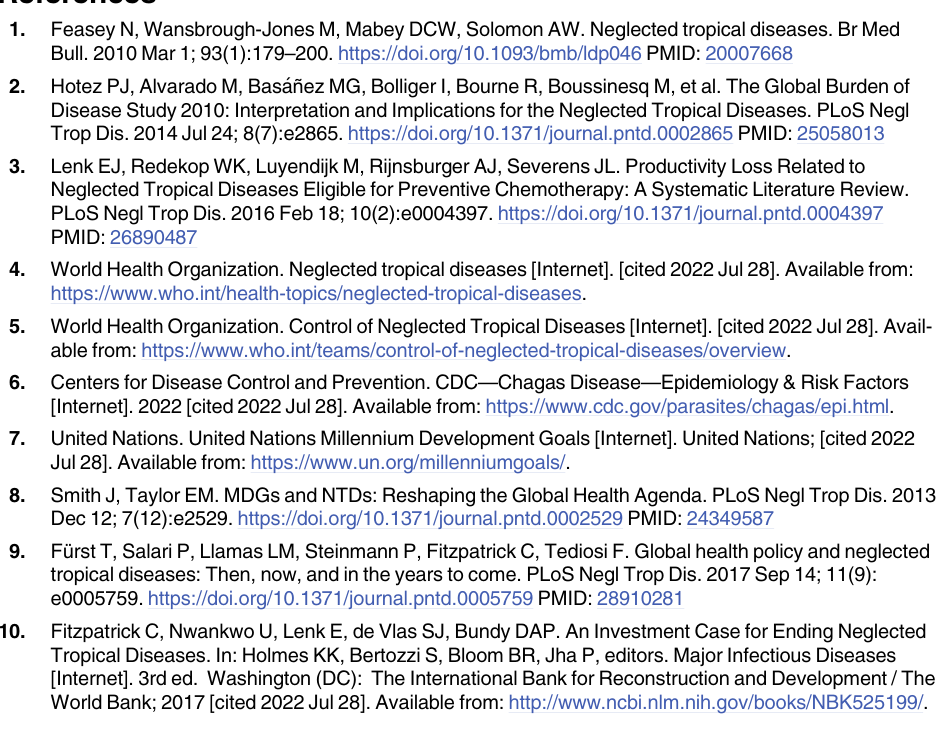
S3 Table. List of grants awarded by FDA through the Orphan Products Grants Program to support the development of safe and effective tropical disease medical products. The list includes the product name, indication, start date, end date, title of study, and the company. The FDA orphan products grants program database was accessed through https://www.